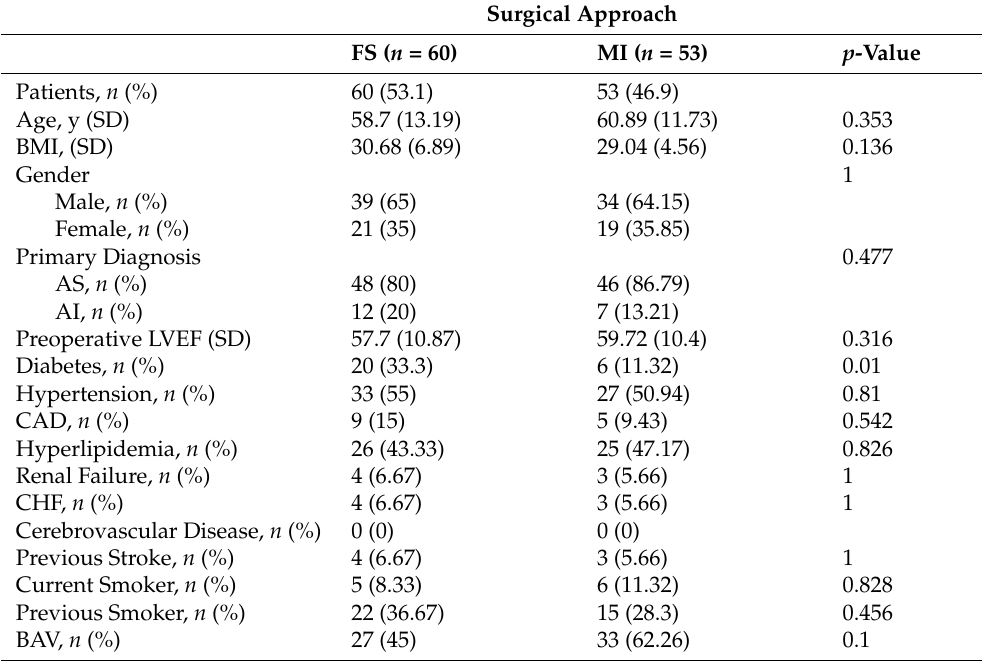
Table 1. Preoperative